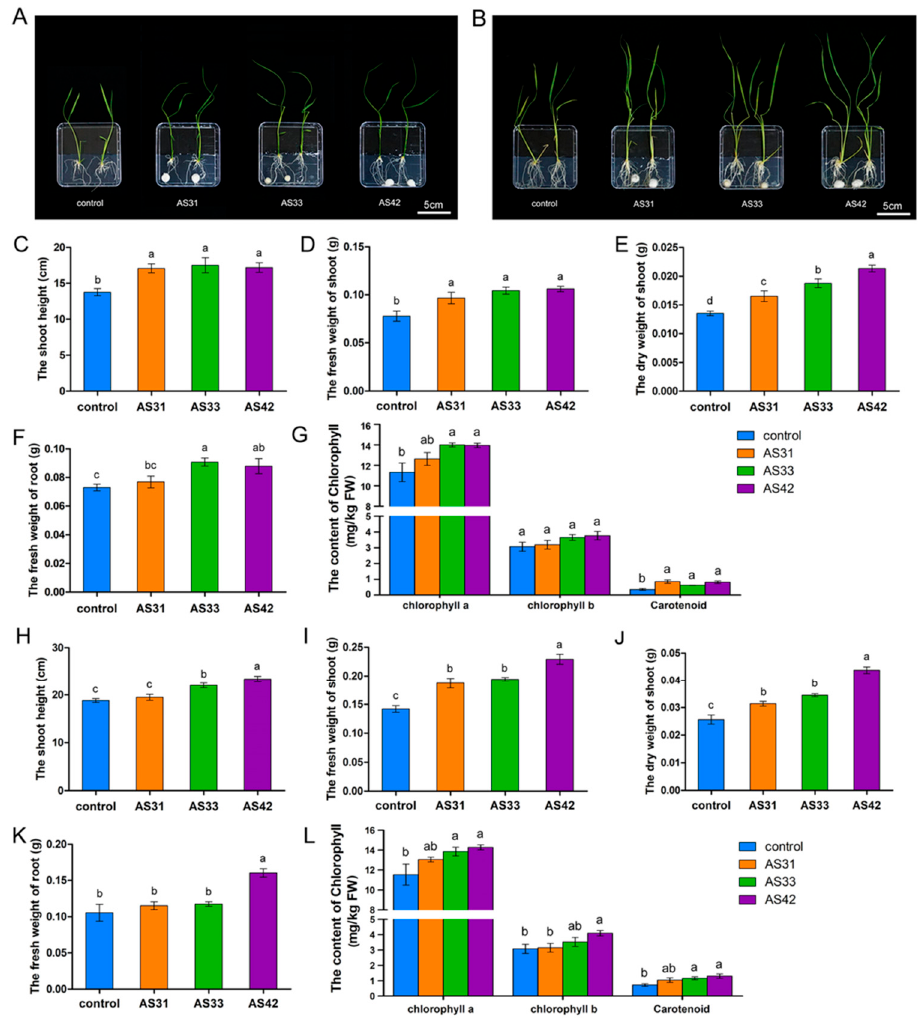
Figure 3. Differential rice responses to inoculation with strains AS31, AS33, or AS42 at the phenotypic level. ( A , B ), Promotion of rice growth by the three strains at 7 ( A ) and 14 ( B ) days after inoculation. ( C – G ), The shoot height ( C ), fresh weight ( D ), dry weight ( E ), root fresh weight ( F ), and the content of chlorophyll ( G ) of rice inoculated with strains AS31, AS33, or AS42 for 7 days. ( H – L ), The shoot height ( H ), fresh weight ( I ), dry weight ( J ), root fresh weight ( K ), and the content of chlorophyll ( L ) of rice inoculated with strains AS31, AS33, or AS42 for 14 days. Data represent the means ± SD of three biological replicates per treatment. Different letters indicate significant differences according to Duncan’s multiple range test. Values of p < 0.05 are considered significant.